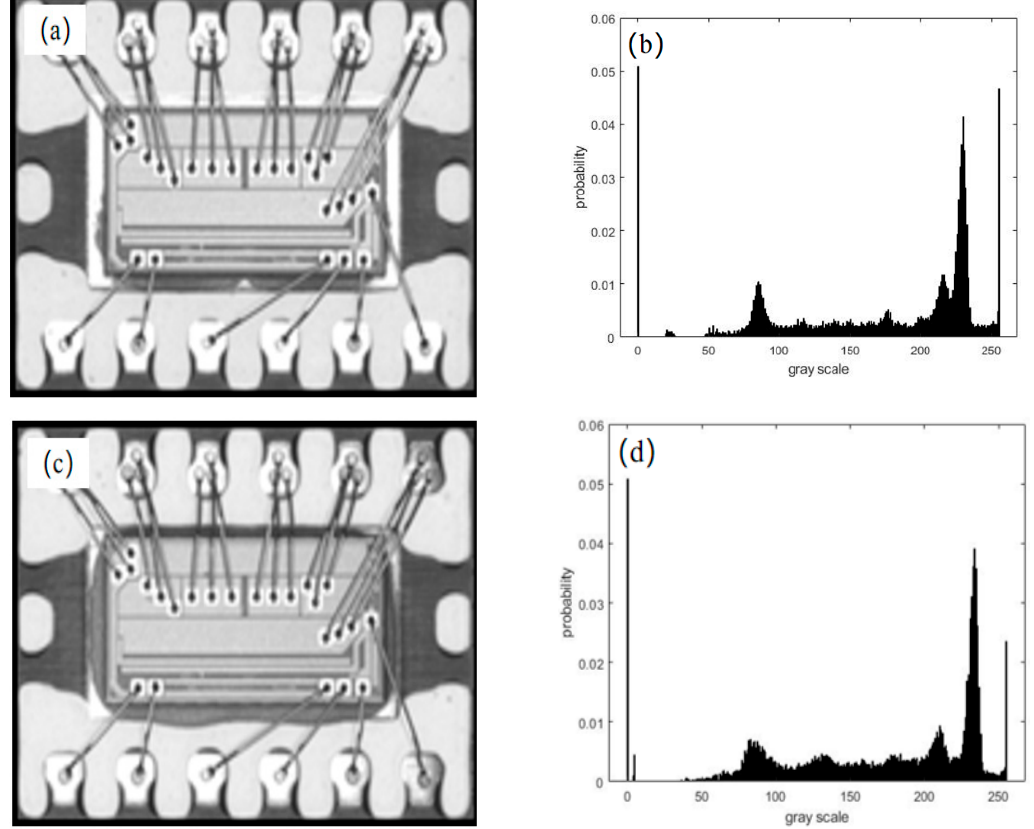
Figure 4. Plastic package side of chip image and its gray histogram. ( a ) Plastic package side in bright field; ( b ) gray histogram of plastic package side in bright field; ( c ) plastic package side in dark field; ( d ) gray histogram of plastic package side in dark field.